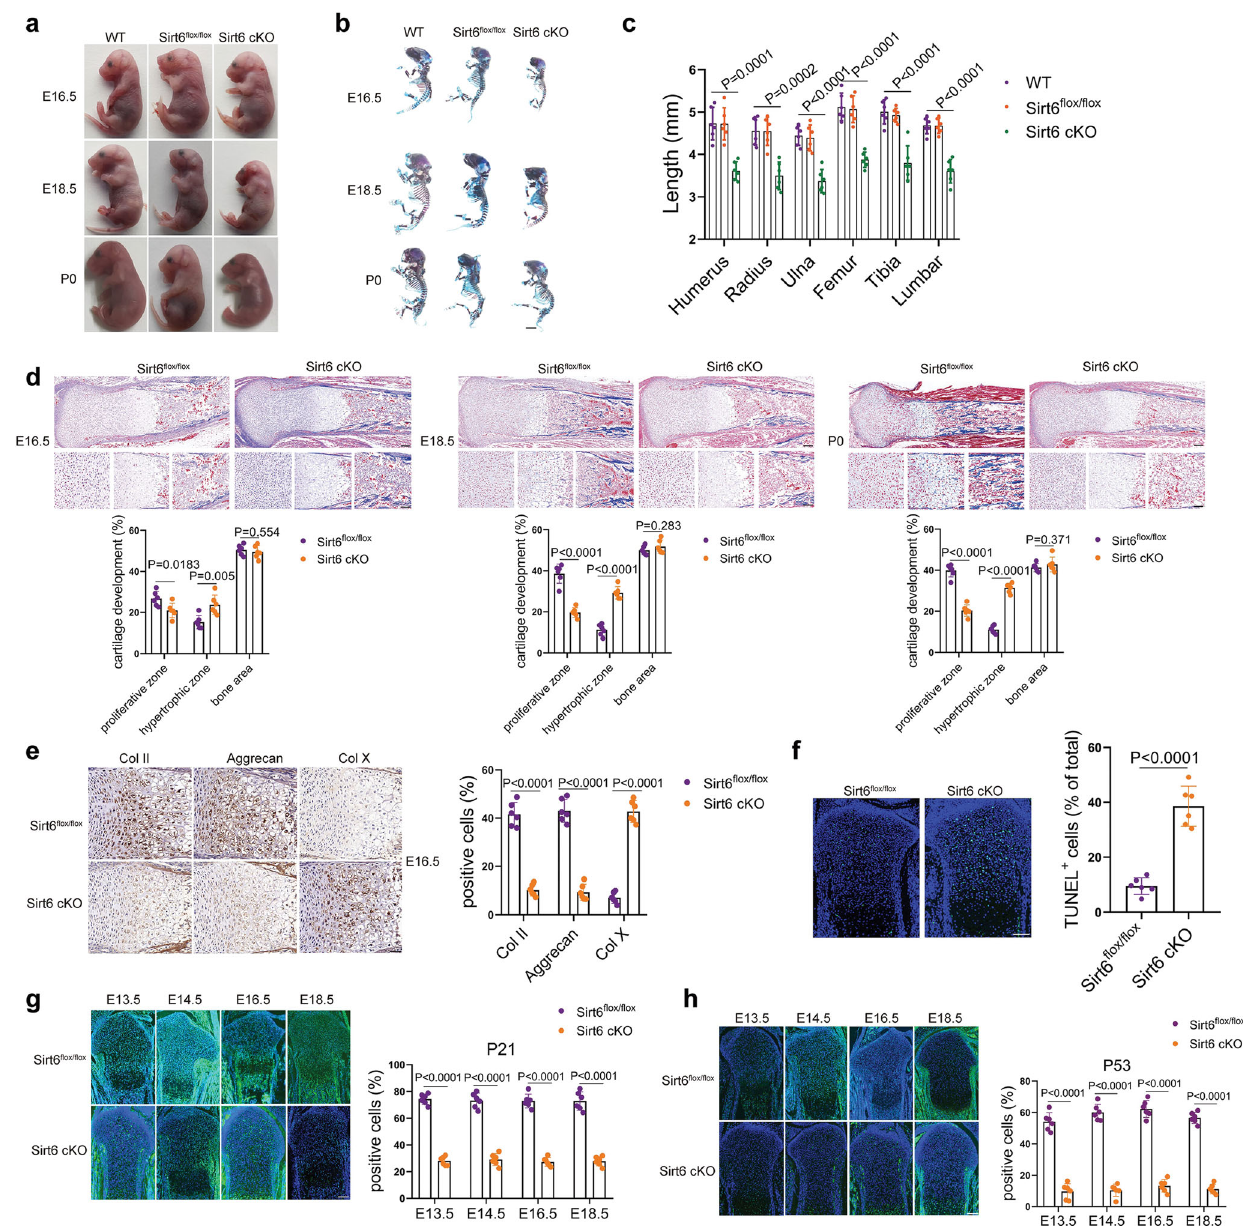
Fig. 2 | Sirt6 regulates cartilage development and embryonic chondrocyte senescence. a – c Gross appearanceofSirt6 fl ox/ fl ox and Sirt6 cKO( a ),double staining with alizarin red and alcian blue of the whole skeleton of Sirt6 fl ox/ fl ox and Sirt6 cKO littermateembryos(E16.5,E18.5,andP0)( b )andlengthoflongbonesandvertebra ( fi rst to fi fth lumbar spines) of Sirt6 fl ox/ fl ox and Sirt6 cKO littermate embryos (E18.5) ( c ). n =6 mice per group. d Masson trichrome staining of whole tibias. The per- centage of the length of the bone area, hypertrophic zone, and proliferative zone over the total tibia length of Sirt6 fl ox/ fl ox and Sirt6 cKO littermate embryos (E16.5, E18.5, and P0). n =6 mice per group. e Representative immunohistochemistry